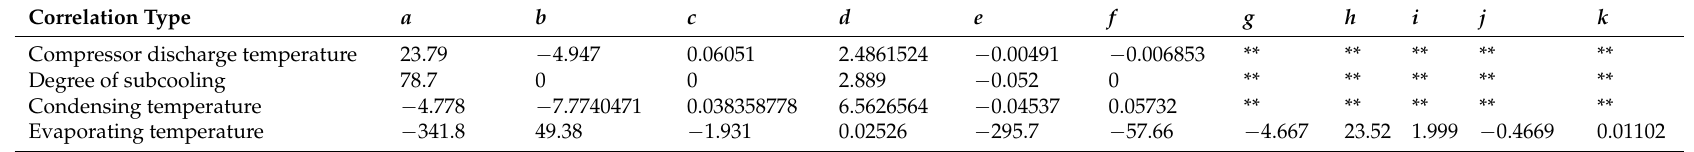
Table 4. Coefficients of refrigerant charge correlations in cooling mode.